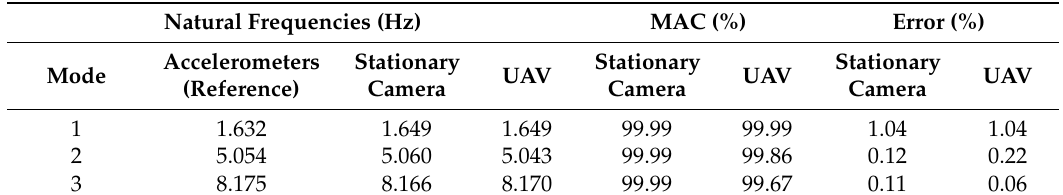
Table 1. Comparison of system identification results.